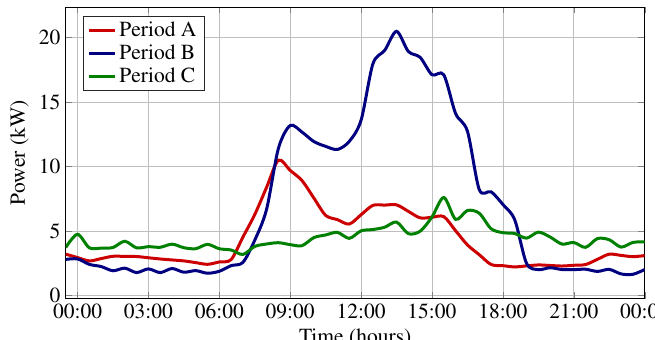
Figure 13. Averaged daily power profile for three periods of the